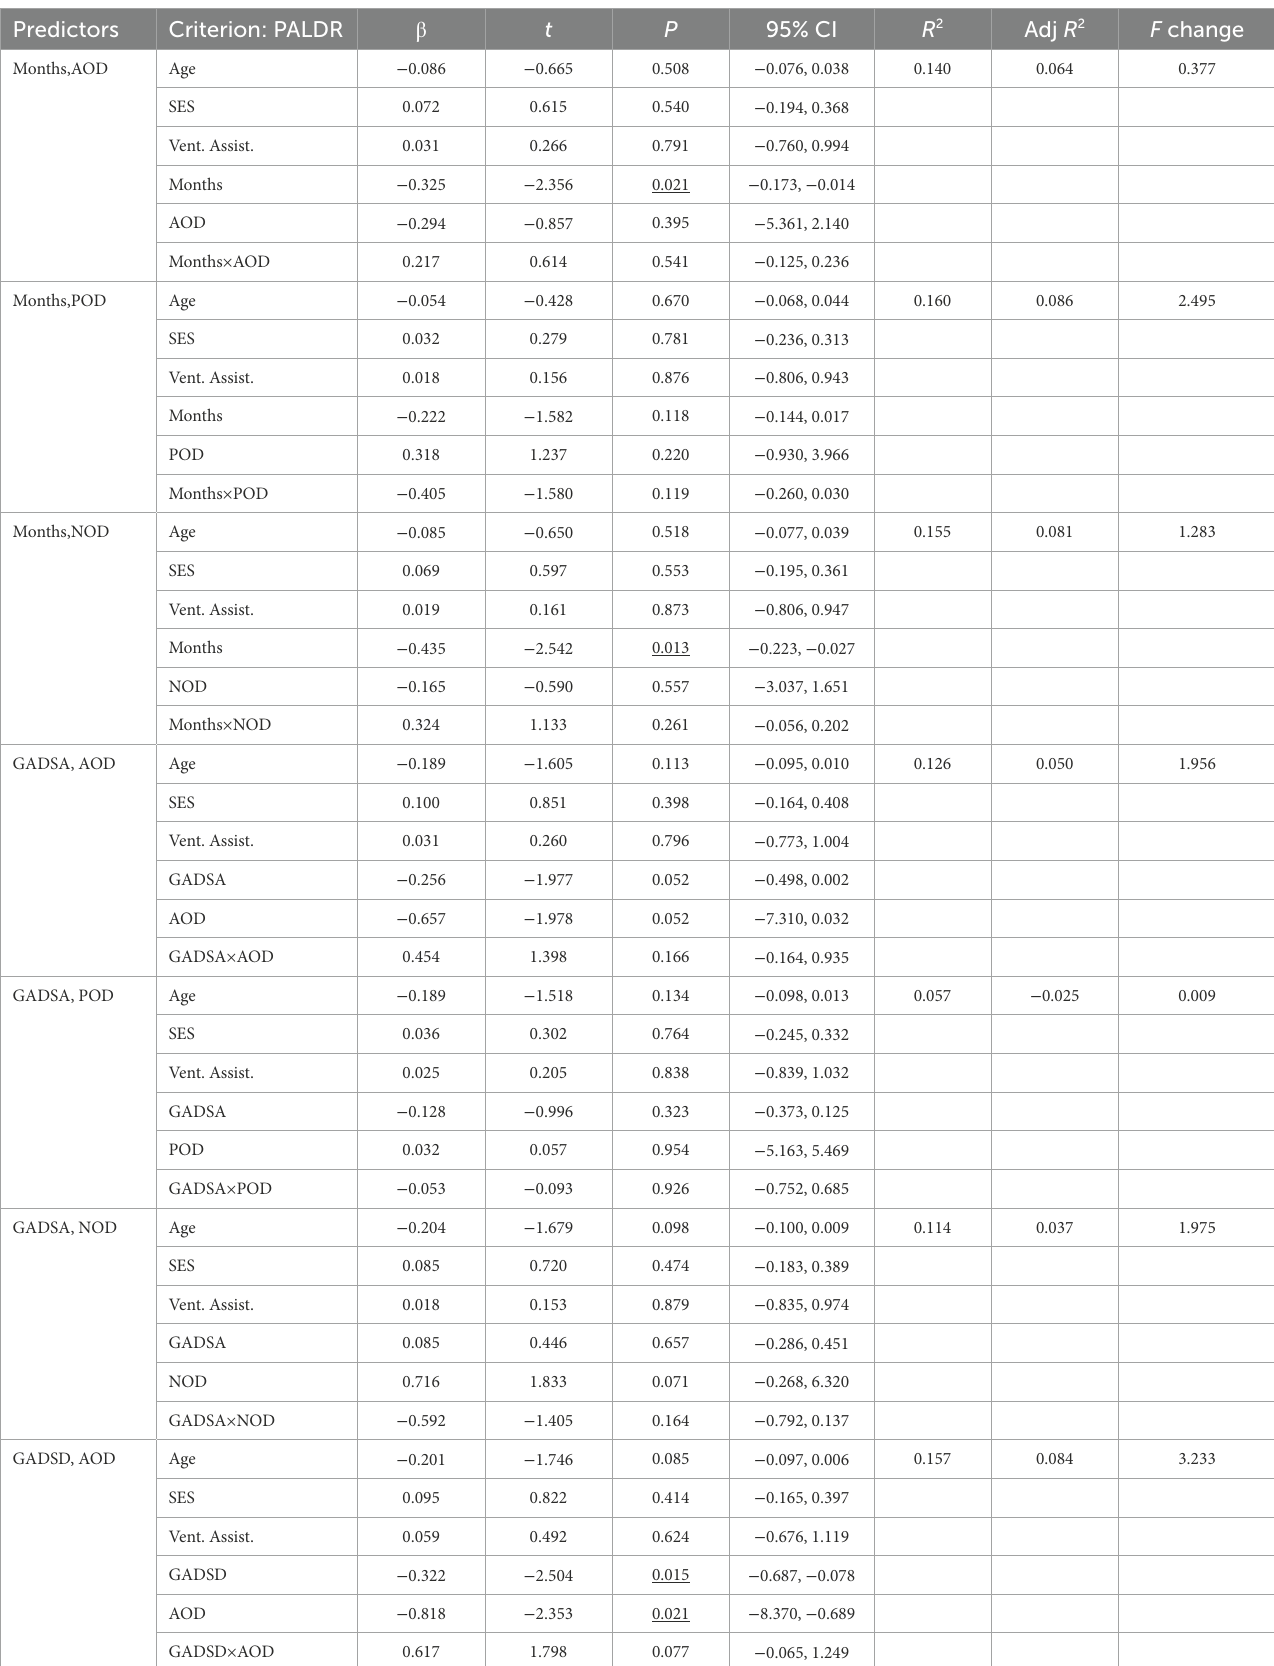
TABLE 8 Multiple regressions predicting delayed ability to recall verbal episodic information (PALDR score), with months since COVID-19 onset, symptoms of anxiety and depression, trait-anxiety, and olfactory dysfunction as predictors.